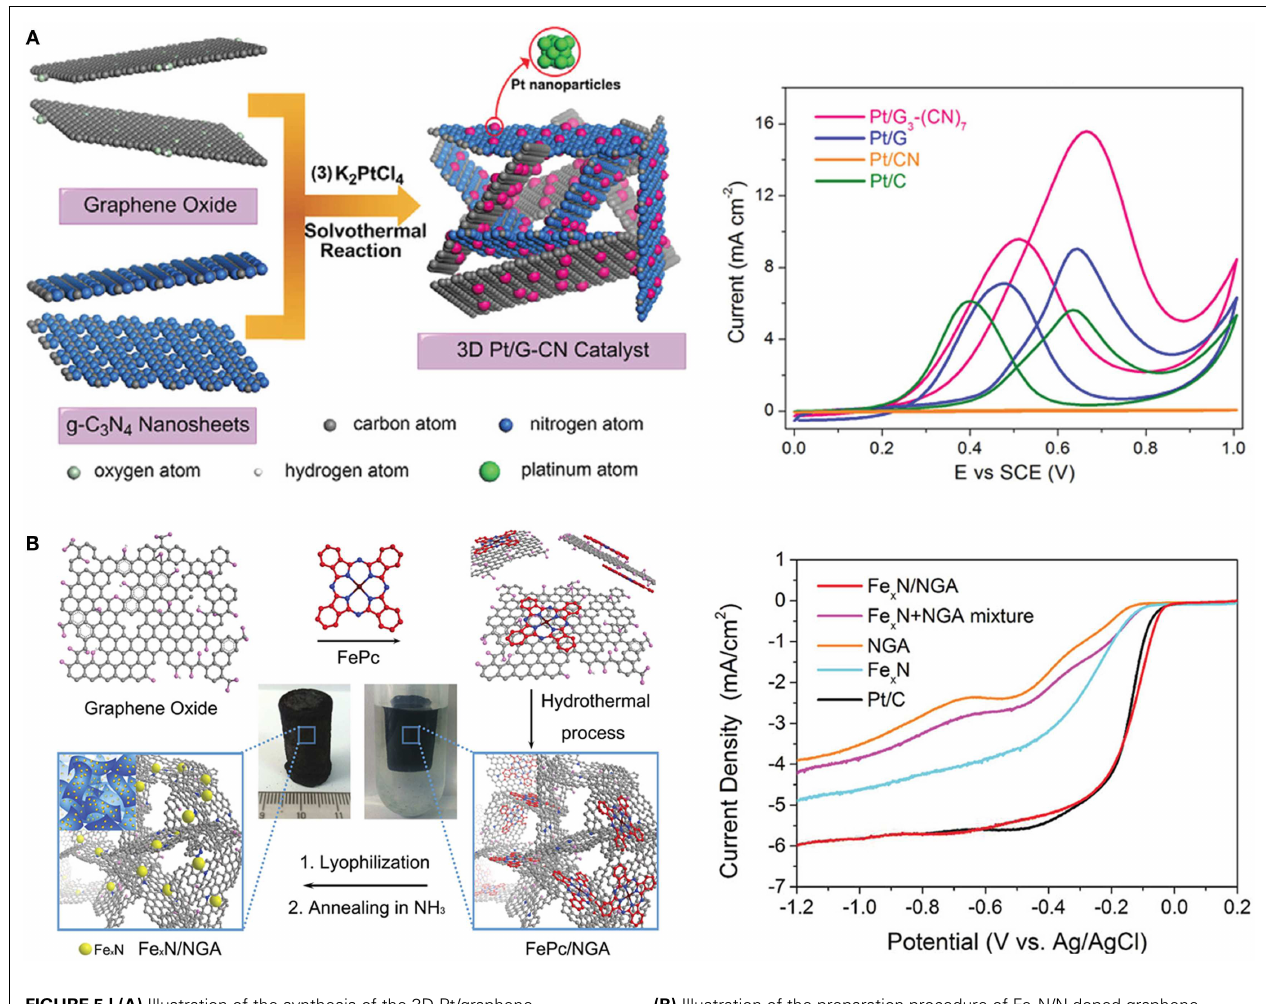
FIGURE 5 | (A) Illustration of the synthesis of the 3D Pt/graphene– carbon nitride catalyst and its electrochemical performance in direct methanol fuel cell. Adapted with permission from Huang et al. (2014). Copyright 2014WILEY-VCHVerlag GmbH & Co. KGaA,Weinheim.